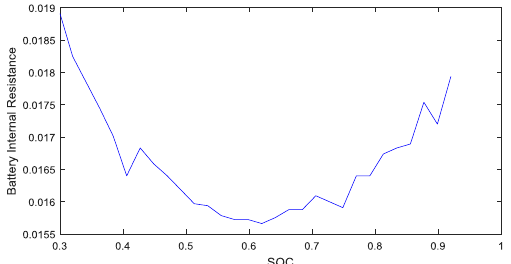
Figure 8. Relation between battery state of charge (SOC) and internal resistance during battery discharge.